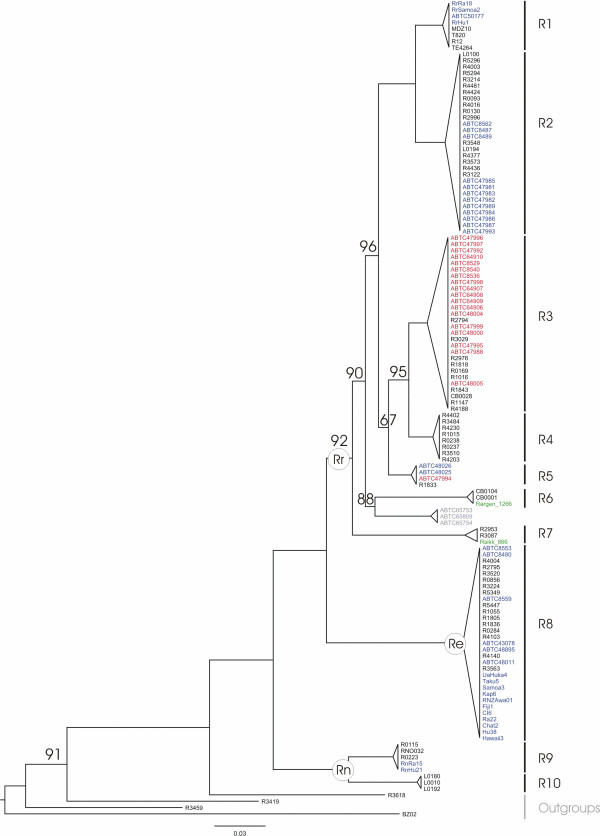
ML tree depicting relationships within the Rattus division on the basis of mt dataset and estimated using partitioned ML analysis. Bp values are shown above branches. Bp values equal to 100% are not indicated. Robins' sequences are highlighted in blue when nominal and phylogenetic species are congruent, in red on the contrary (see also Table 3). Rattus hoffmanni sequences are indicated in grey; sequences provided by Verneau and Catzeflis in green. Rr for Rattus rattus species group, Re for Rattus exulans species group, Rn for Rattus norvegicus species group. At the right hand of the tree, cluster denomination is the same as in the Figure 3.